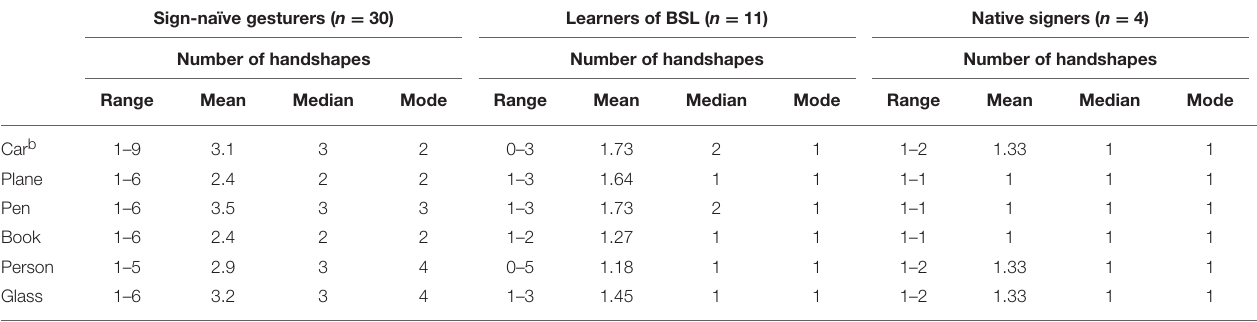
TABLE 1 | Inter-trial consistency of handshapes chosen for six objects by three groups: sign-naïve gesturers, learners of BSL, and native signers a . Sign-naïve gesturers ( n =